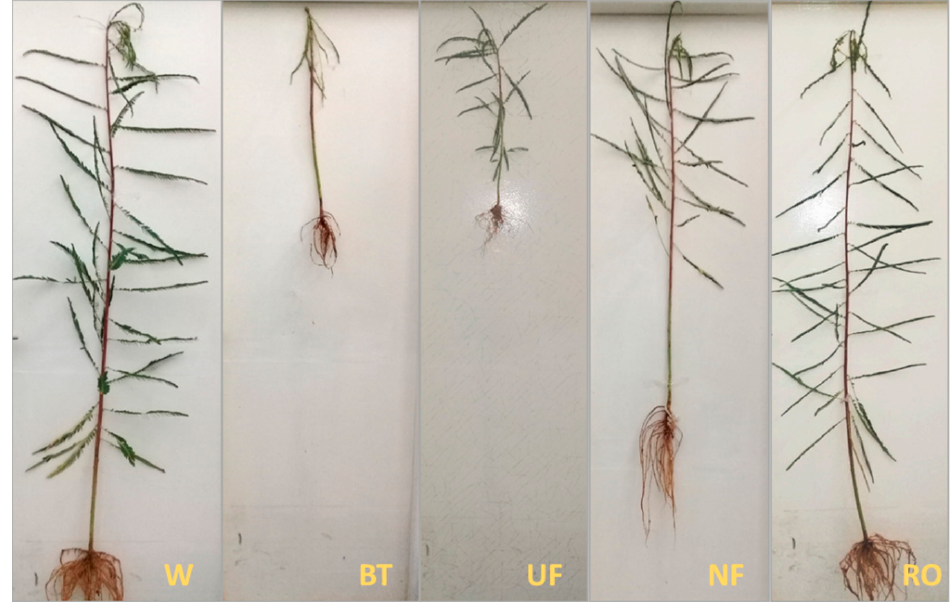
Figure 3. Effect of TTE irrigation on the growth of aerial parts of Sesbania bispinosa . W: Well water; BT: Biological treatment; UF: Ultrafiltration; NF: Nanofiltration; and RO: Reverse Osmosis.